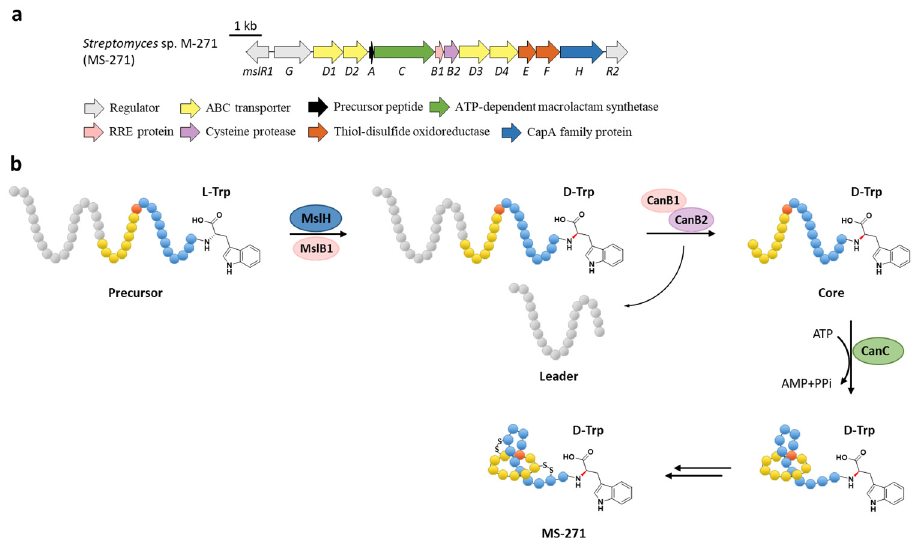
Figure 7. The BGC ( a ) and proposed biosynthetic pathway ( b ) of MS-271. MslH epimerizes the C-terminal Trp residue of precursor peptide with the aid of MslB1, similar to the cooperation of CanE and CanB1 in Section 6.